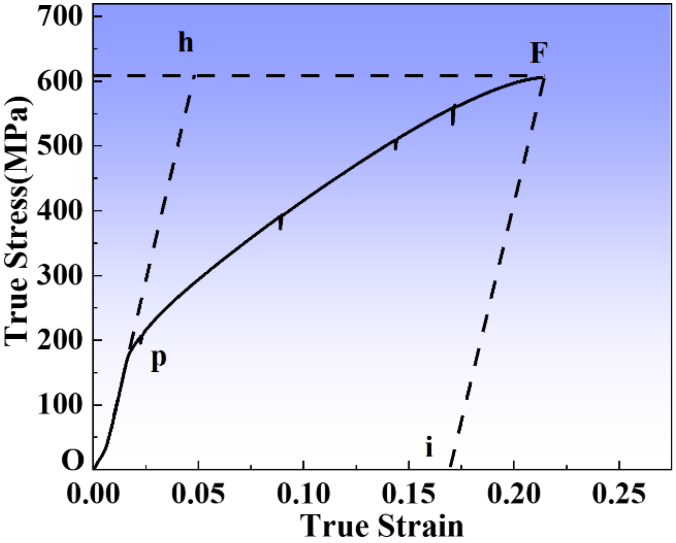
Figure 2. In situ tensile true stress–strain curve. (The OP of the curve corresponds to the elastic deformation and the PF corresponds to the elastoplastic deformation).